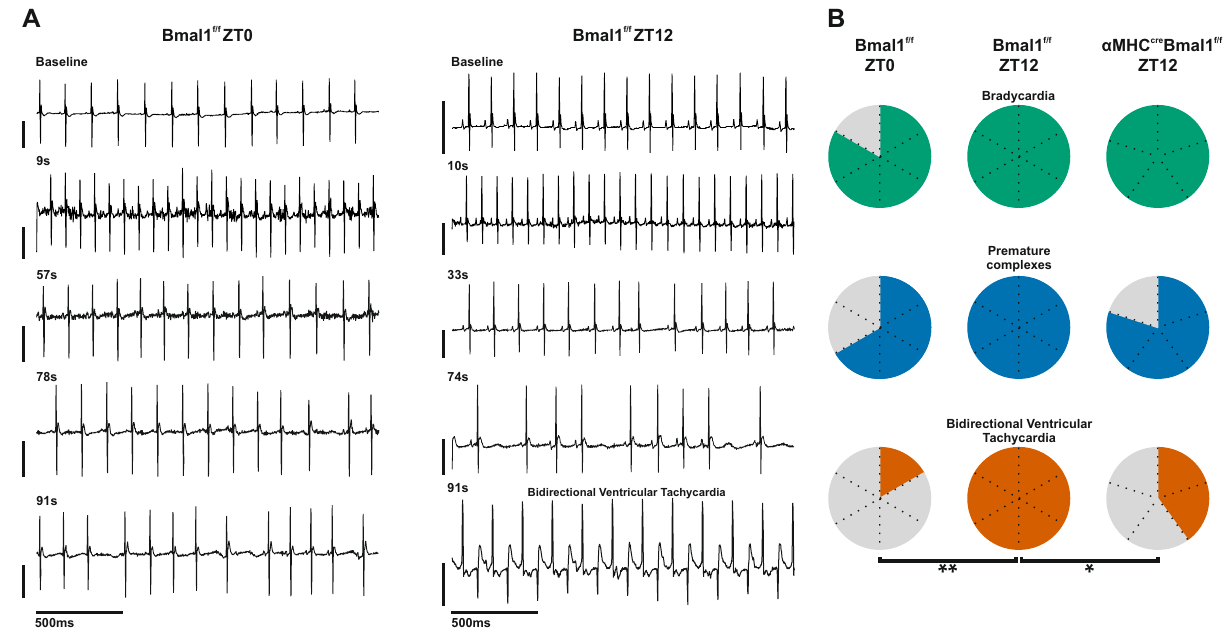
Fig. 6 In vivo propensity for catecholamine-induced bidirectional VT displays diurnal rhythmicity. A Typical ECG traces before (baseline) and after injection of caffeine and adrenaline. Animals displayed rapid tachycardia, typically followed by bradycardia and sinus pauses and/or premature complexes, with some progressing into bidirectional VT (bottom right). Vertical scale bars represent 0.5 mV and inset times are time from returning to the cage after injection. B Proportion of animals that display evidence of each stage of VT progression. At ZT12, all control animals (six of six mice tested) displayed robust evidence of bidirectional VT, compared to only one of six mice tested at ZT0. Only two of fi ve α MHC CRE Bmal1 Fl/Fl mice displayed bidirectional VT at ZT12. * P < 0.05, ** P < 0.01, Chi-square. Source data and statistical details are provided as a Source Data